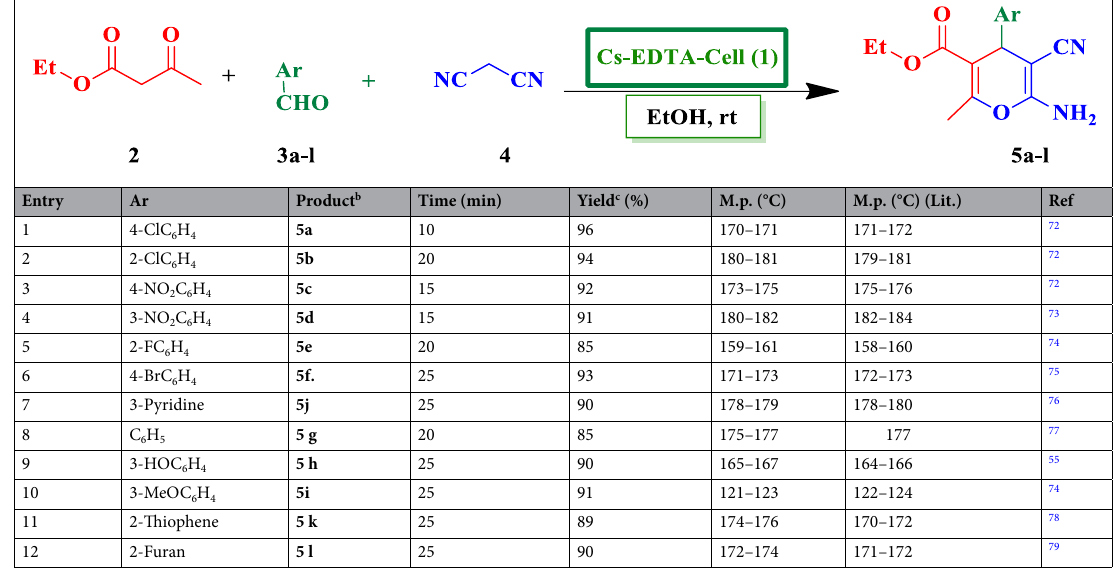
Table 2. Scope of the synthesis of 2 ‐ amino ‐ 3-cyano-4 H ‐ pyran derivatives 5a-l catalyzed by Cs-EDTA-Cell ( 1 ) under optimized reaction conditions a . a Reaction conditions: ethyl acetoacetate ( 2 , 1.0 mmol), aldehyde ( 3a-l , 1.0 mmol) and malononirile ( 4 , 1.0 mmol) in the presence of Cs-EDTA-Cell network ( 1 , 0.01 g) was added to the EtOH (3.0 ml) at room temperature. b All compounds are known and their structures were established from their spectral data and melting points as compared with literature values. c Yields refer to the isolated